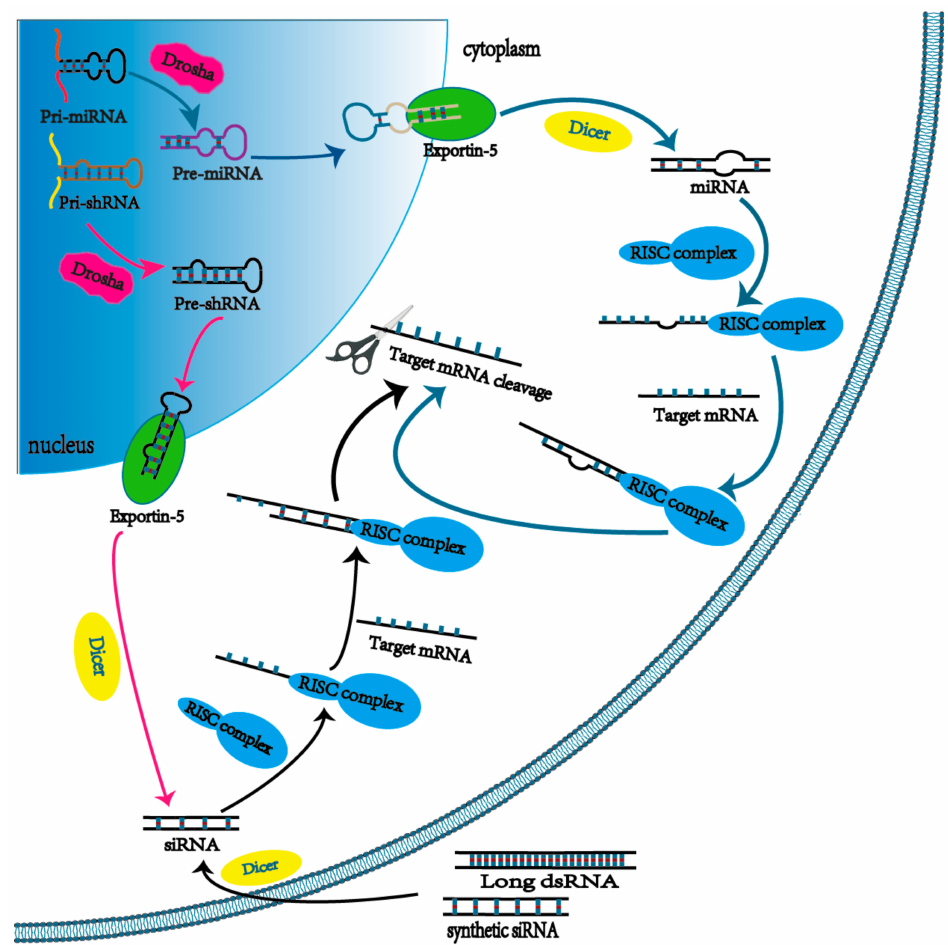
Figure 1. The mechanism behind